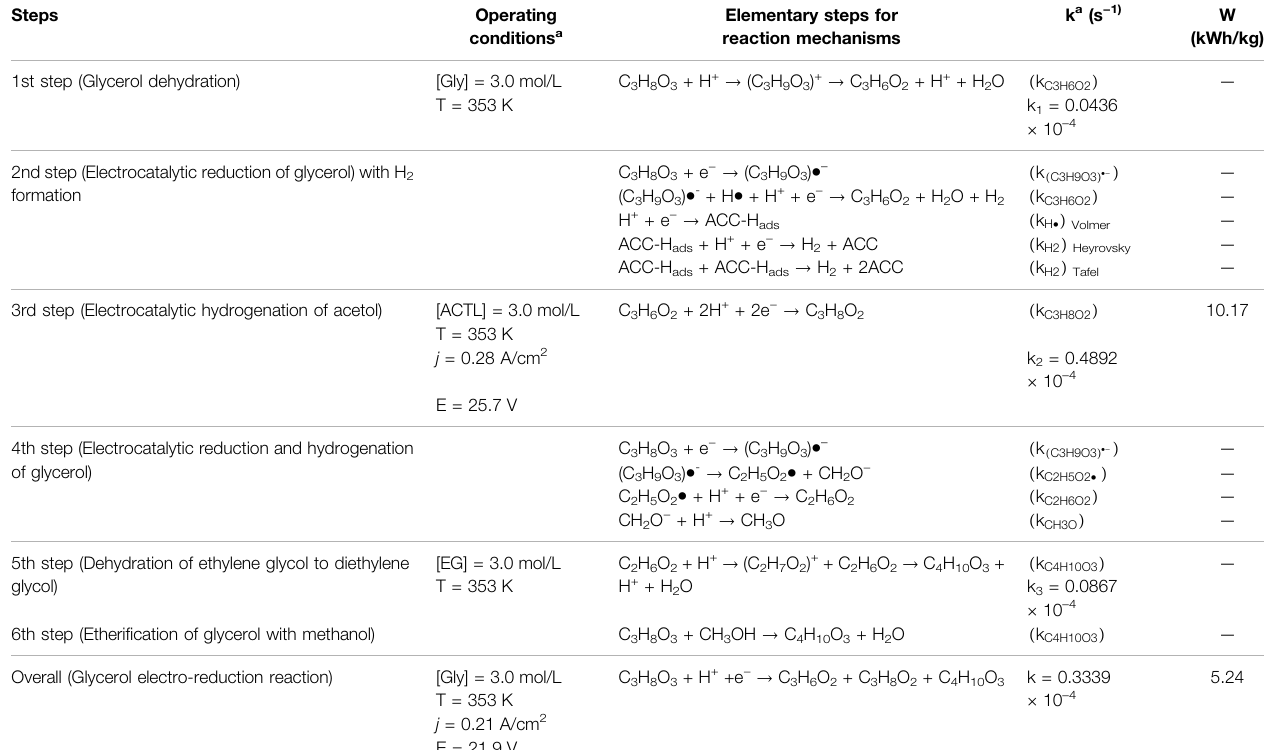
TABLE 2 | Elementary steps for the